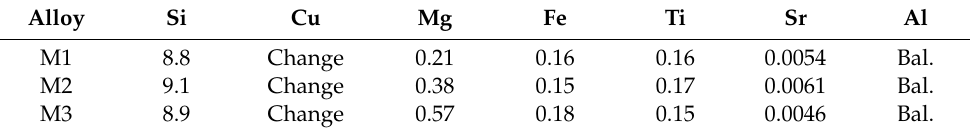
Table 1. Change in Mg element in alloy composition in wt%.